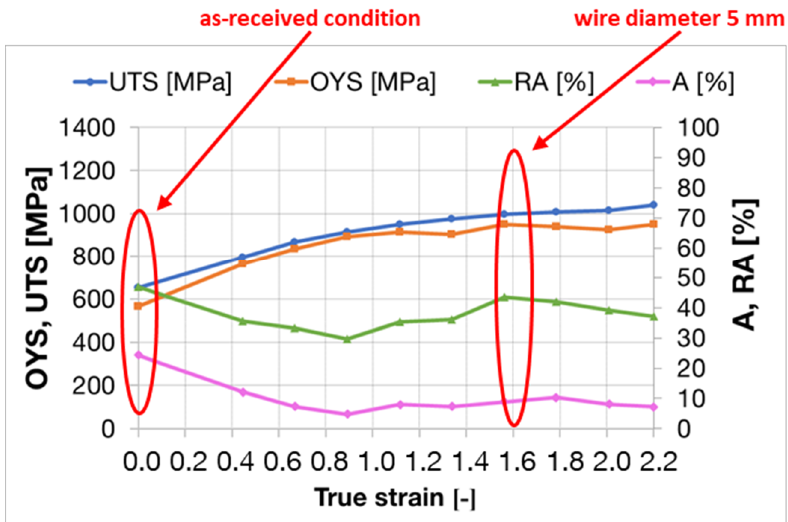
Figure 17. Results of tensile testing for titanium Grade 2 after rotary swaging as a function of the true strain induced by rotary swaging.